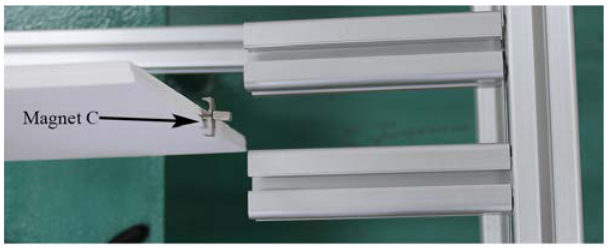
Figure 6. One stable position of the linear flutter energy harvester (LFEH).